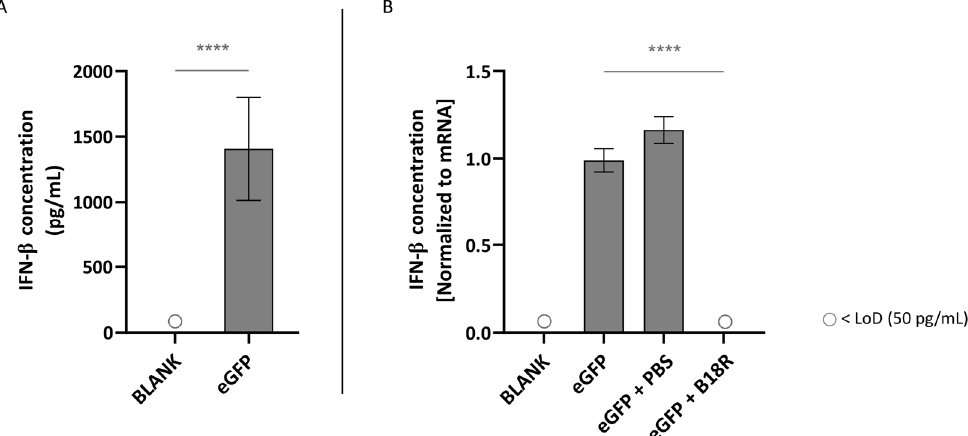
Figure 3. Interferon-β (IFN-β) production of ARPE-19 cells transfected with mRNA-MessengerMAX lipoplexes with or without B18R co-incubation as determined by ELISA (n = 3 × 3). ( A ) Absolute INF-β concentration in the supernatant 24 h following transfection of ARPE-19 cells with mRNA- MessengerMAX complexes without B18R addition. ( B ) IFN-β concentration, normalized to the group solely receiving mRNA-MessengerMAX complexes (eGFP), in the supernatant of ARPE-19 cells 24 h after transfection with mRNA-MessengerMAX complexes with or without B18R addition. The lowest concentration of IFN-β that could be detected with the used ELISA assay (LoD) was 50 pg/mL. Concentrations below the LoD are assigned with ○ , **** p < 0.0001.